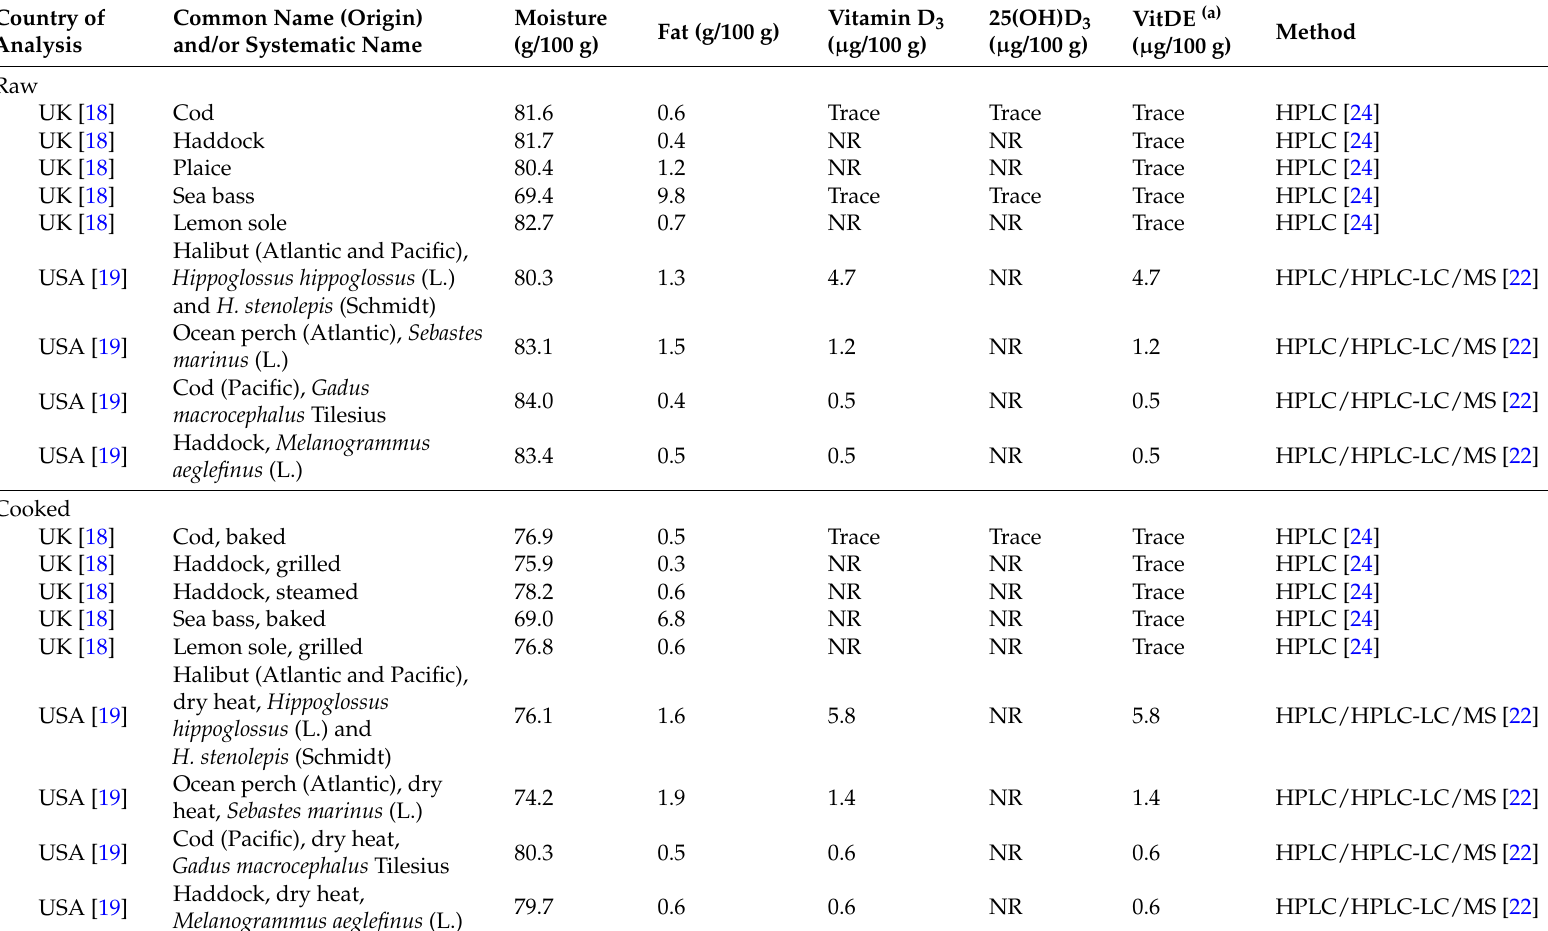
Table 4. Internationally sourced data for moisture, fat, vitamin D 3 , 25-hydroxyvitamin D 3 and vitamin D equivalents in white fish. Country